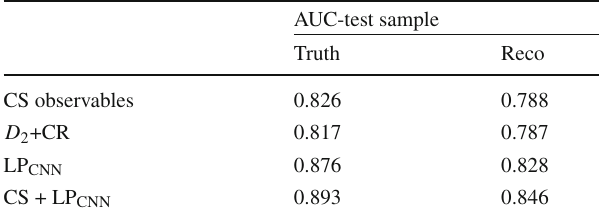
Table 2 Area under the ROC curves for different combination of observables